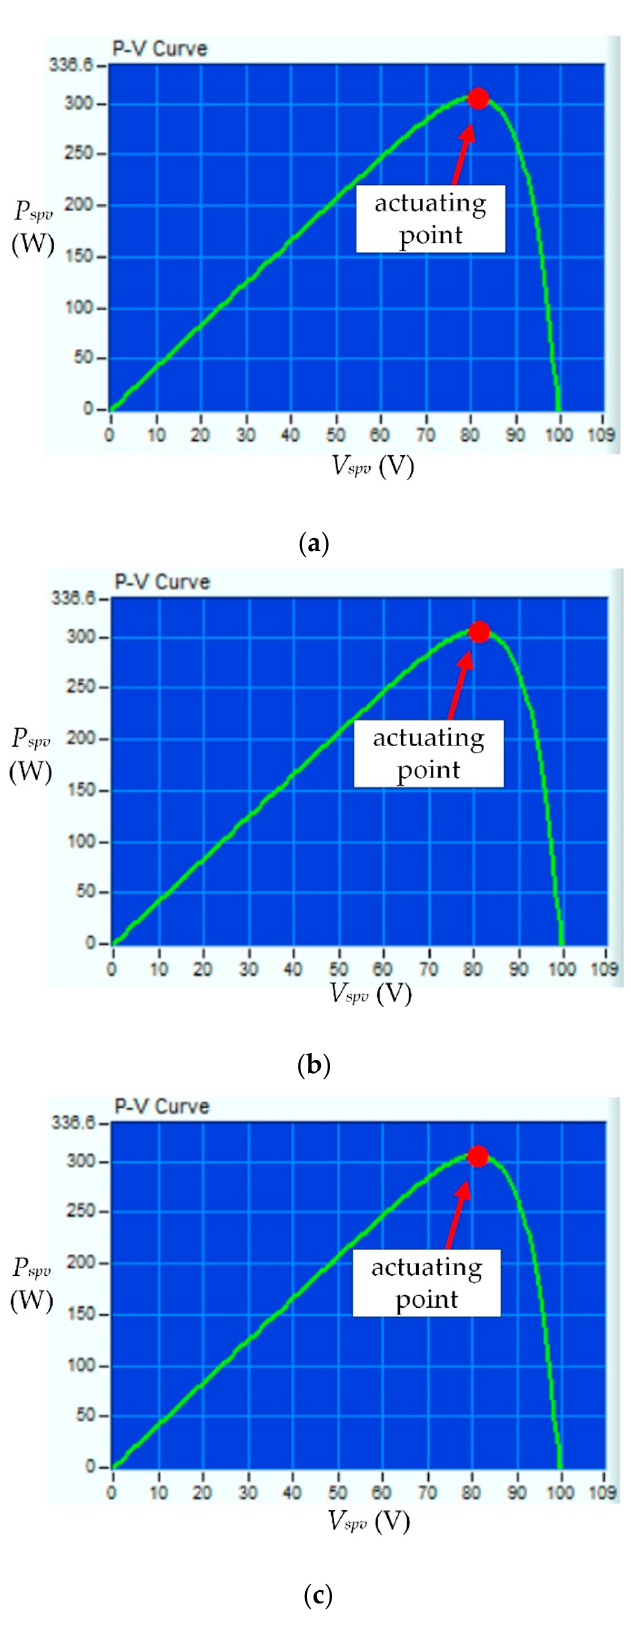
Figure 13. The waveforms of v gs , V o , I o , and P o under UIC with IL = 700 W/m 2 and temperature = 25 °C by implementing the control strategy ( a ) SLOPDM, ( b ) SAH, and ( c ) P&O algorithms. (Horizon- tal axis: 2 s/div).